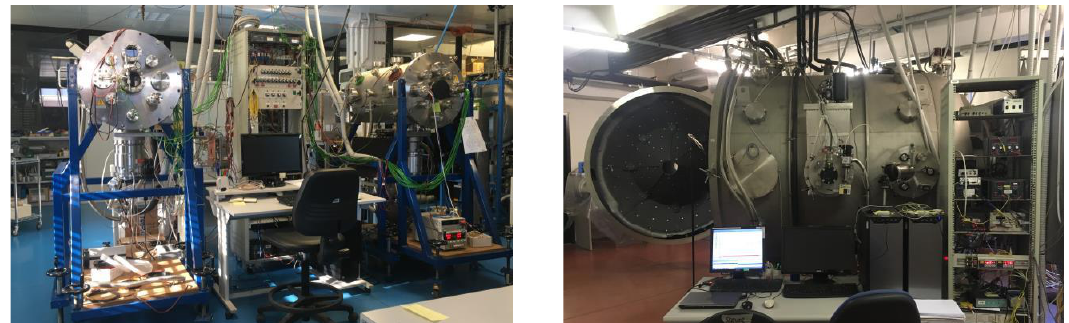
Figure 4. IV7 and IV8 vacuum chambers (left). IV4 vacuum chamber